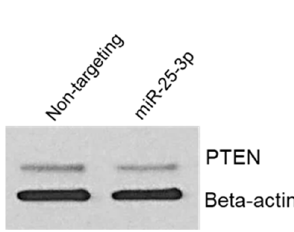
Figure 5. miR ‐ 451a decreases miR ‐ 25 ‐ 3p expression in endometriotic epithelial 12Z cells. Asterisk indicates statistically significant ( p < 0.01) reduction compared to pre ‐ NT transfected cells. N = 3 replicates.